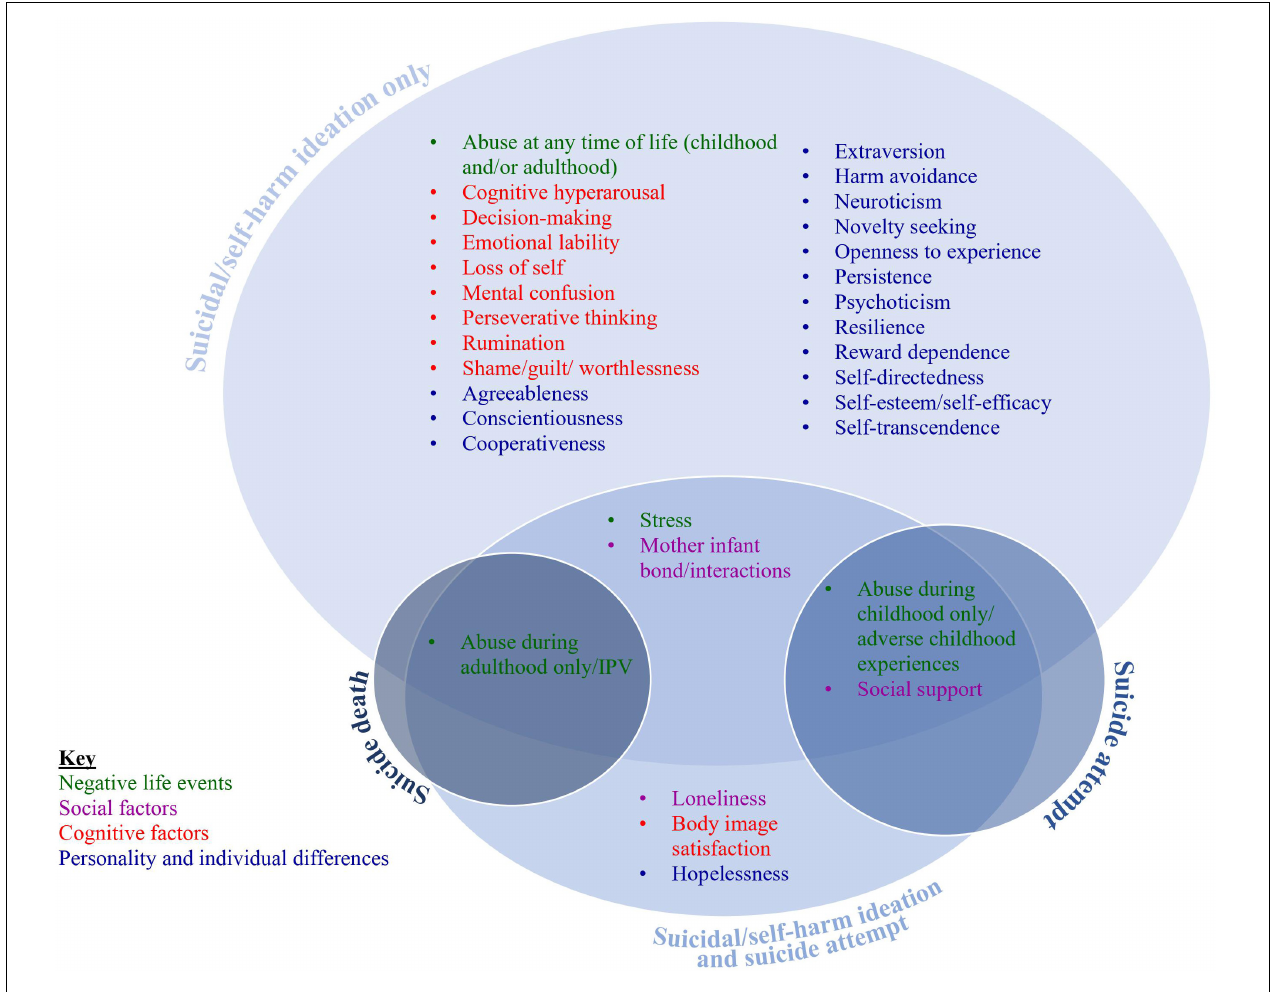
FIGURE 2 | Diagrammatic illustration of the included risk factors and suicide